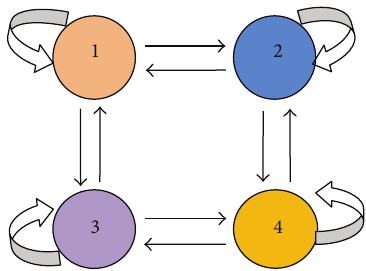
Figure 1: Schematic description of NCSs with random data packet dropouts.